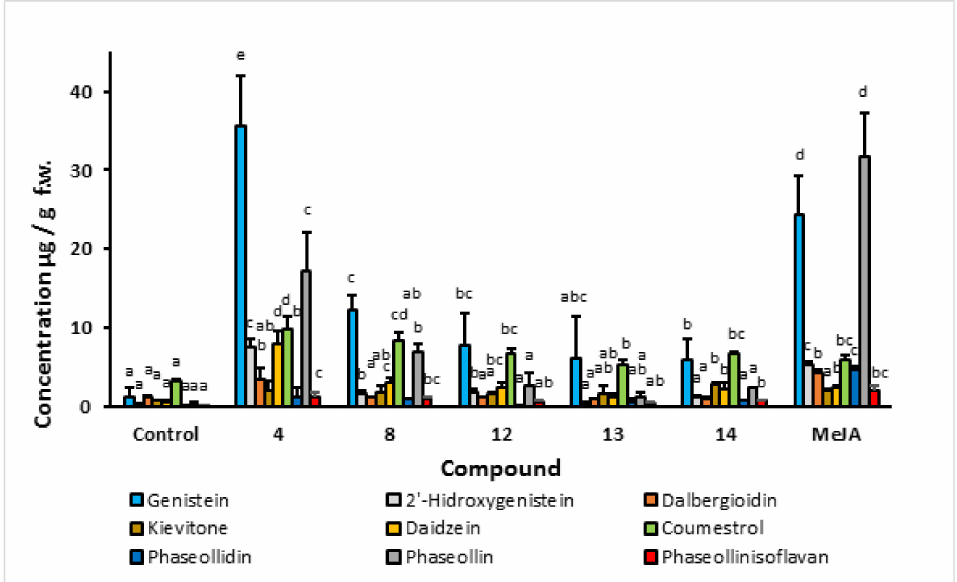
Figure 5. Isoflavonoid phytoalexin accumulation in hypocotyl-root of common bean ( P. vulgaris L. cv. ICA Cerinza) in response to 1-oxo-indanoyl-L-isoleucyl methyl ester derivatives and MeJA treatments 72 h post-induction. Bars denote the mean concentration of isoflavonoids ± s.d. ( n = 3). For each compound, bars with different letters (a–e) are significantly different ( p < 0.05; Fisher’s LSD